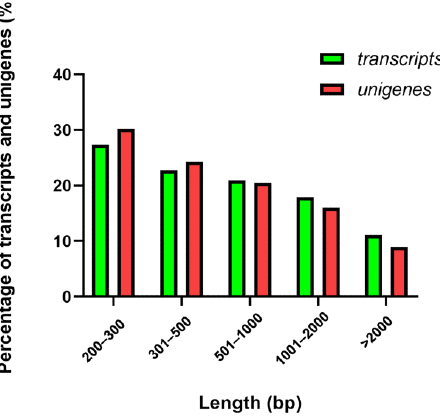
Figure 1. The length distribution of transcripts and unigenes.